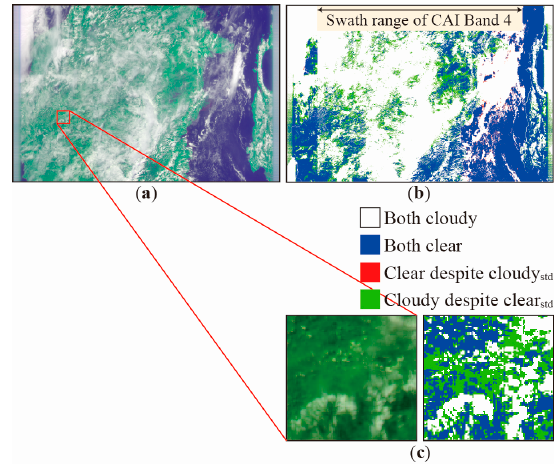
Figure 7. Comparative results for Borneo Island on 2 June 2012. ( a ) Input CAI L1B product (R: Band 2, G: Band 3, B: Band 1); ( b ) Comparative results using SV generated by Procedures 1 and 2 when